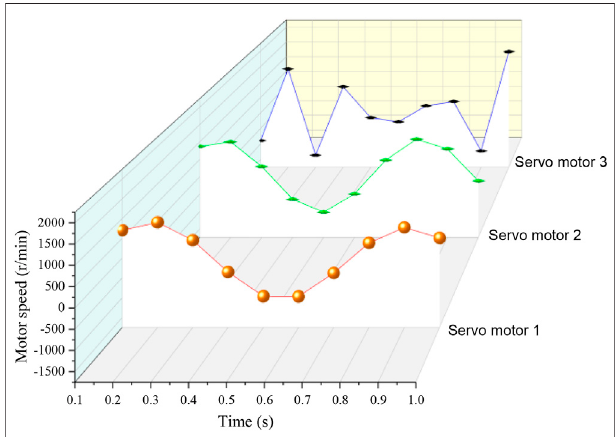
FIGURE 3 | Rotation curve of servo motor.